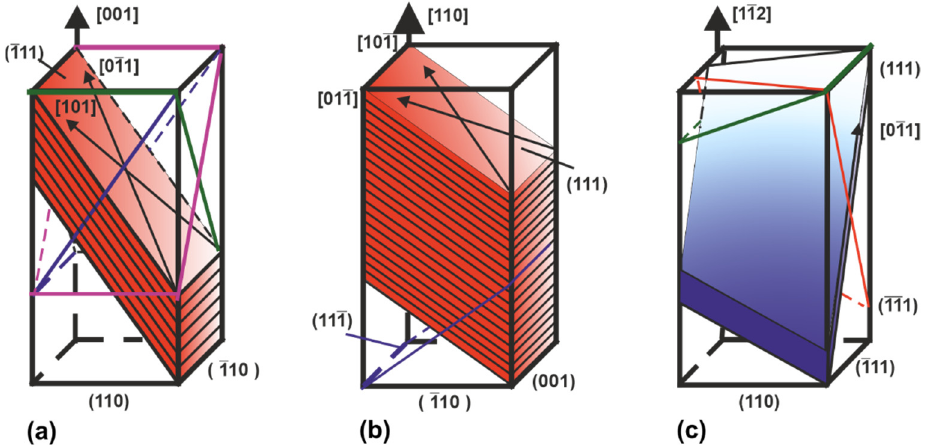
Figure 5. The volume of the single crystals covered by a shear along one system of the most active slip planes (panels ( a – c ) differ in the direction of the deformation axis and the orientation of the lateral faces, which are indicated in the sub ‐ pictures).